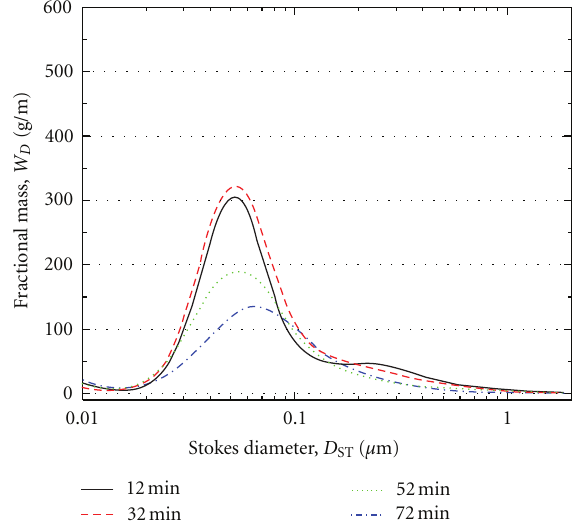
Figure 5: Particle size distributions of Arkema CNTs with increas- ing sonication time using a horn sonicator with flow cell at 70% amplitude.